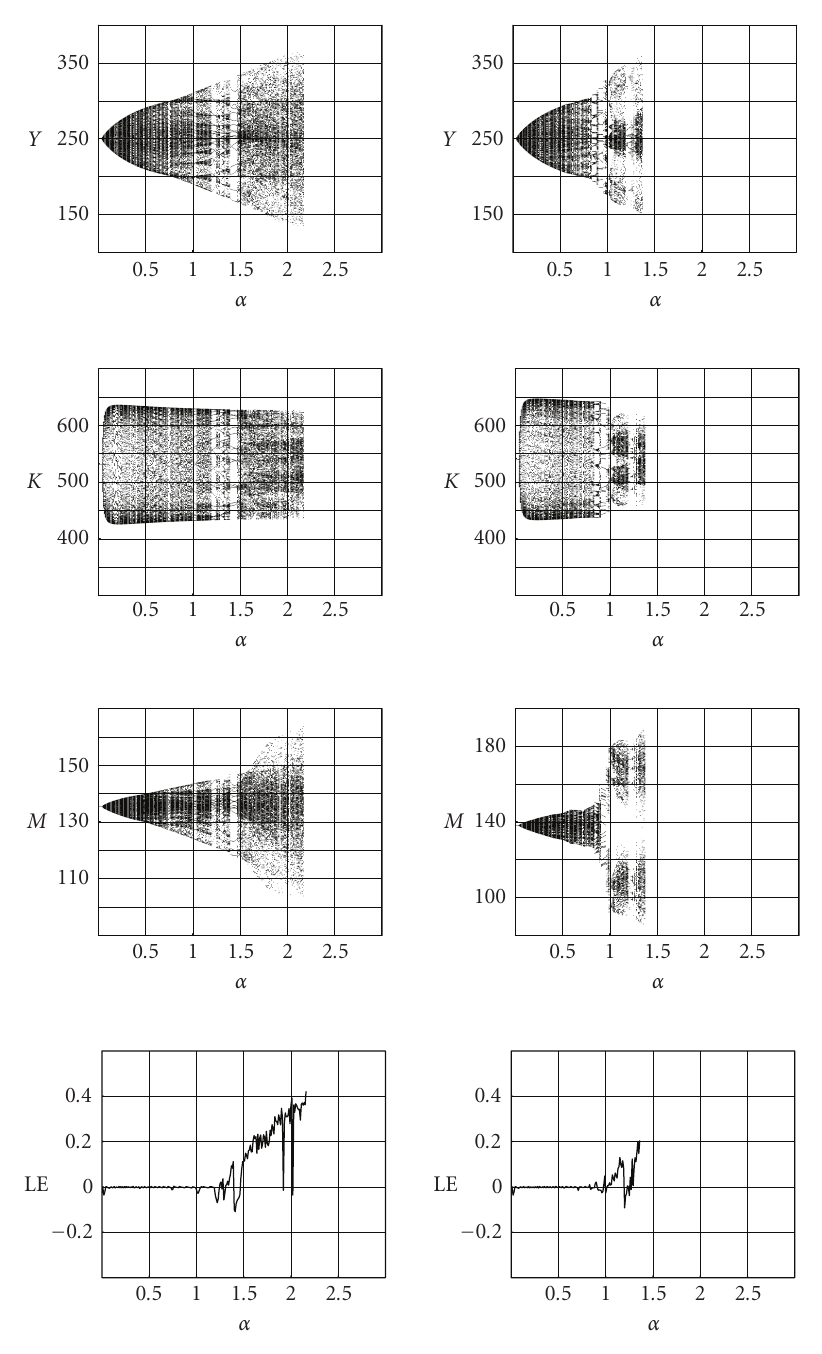
Figure 5.2. Bifurcation diagrams and Lyapunov exponent for β = 1 . 5 (left) and β = 1 . 8